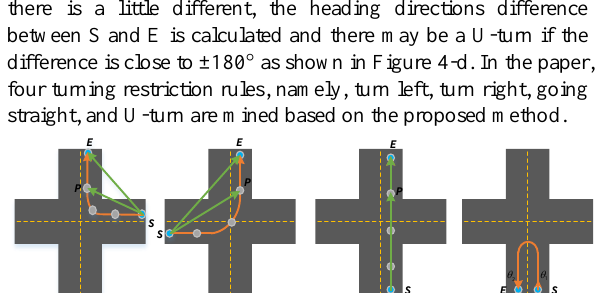
precise geometry of intersections (Figure 5-a), possibly leading to incorrectly delineates the geometry of turning paths (Figure low-frequency trajectory data to fit real turning paths and in the